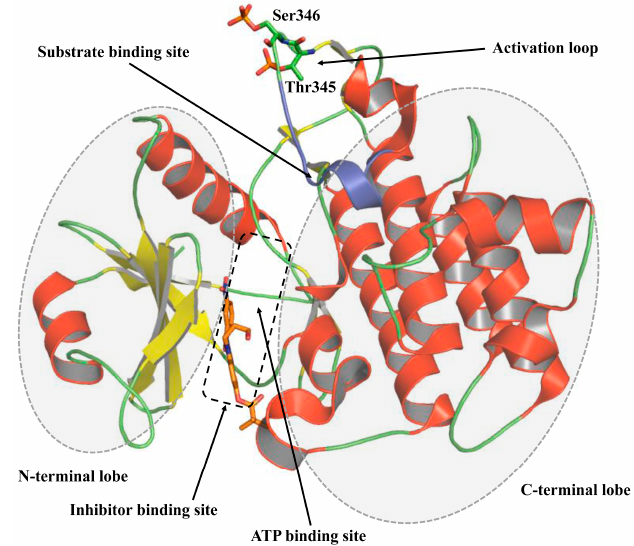
Figure 3. Overall structure of IRAK4 kinase domain. IRAK4 kinase domain consists of an N-terminal and a C-terminal lobe with the ATP-binding pocket lying between the two lobes. The binding site of IRAK4 inhibitors overlaps with that of ATP. The region highlighted in blue color mediates substrate (IRAK1) binding and phosphorylation.